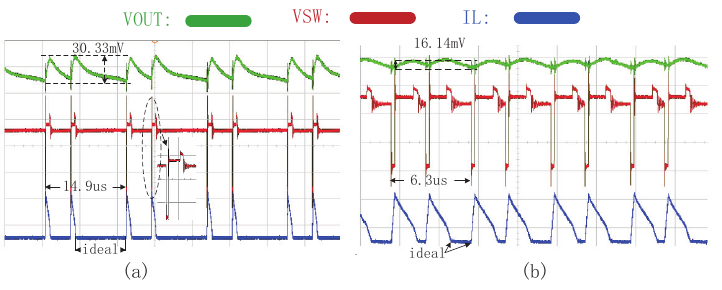
Figure 11. Test results of V OUT , V SW , I SW in DGM operating mode of the proposed DCDC Boost converter. ( a ) When the I load is 5 mA. ( b ) When the I load is 20